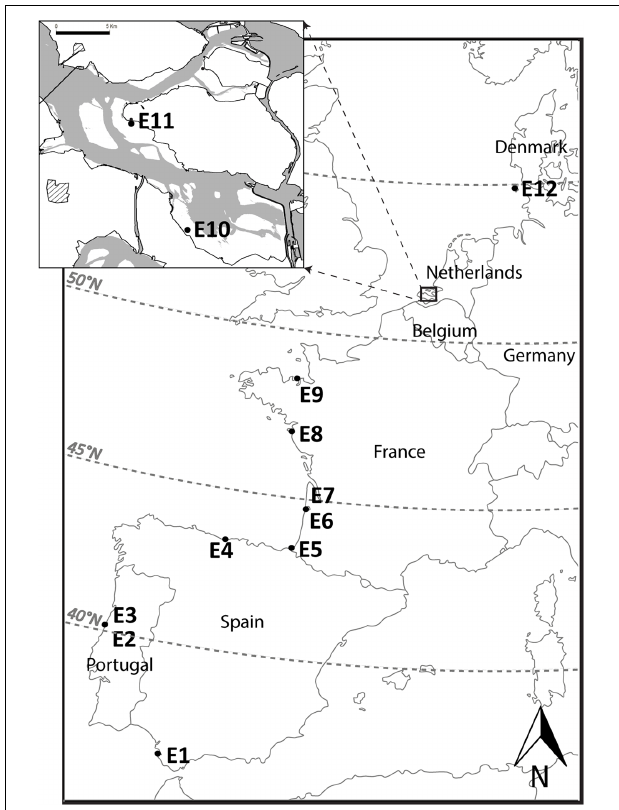
FIGURE 1 | Localization of the sampling sites along the Western European coast, from south to north: E1 Cadiz (Spain); E2 and E3 Mondego estuary (Portugal); E4 Santander (Spain); E5 Bidasoa esturary (France); E6 and E7 Arcachon Bay (France); E8 Noirmoutier (France); E9 St-Jacut-de-la-mer (France); E10 and E11 The Oosterschelde (Netherlands); and E12 Sylt (Germany); Zoom in the case study sites (E10 and E11).